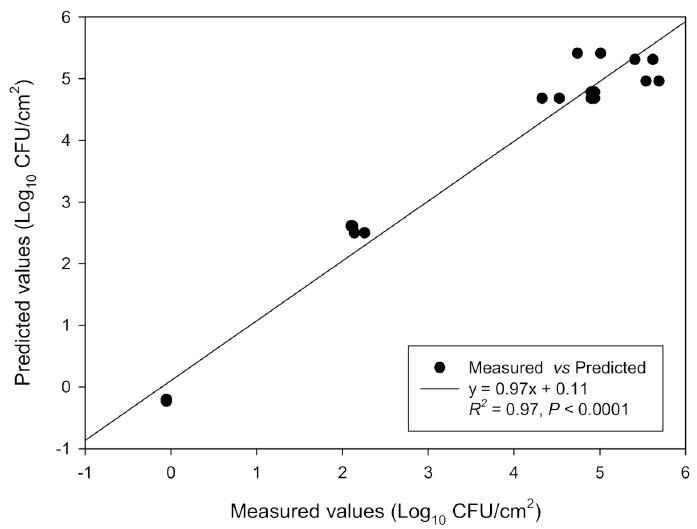
Figure 1. Linear relationship between the measured and predicted data for the concentrations of the attached to SS coupons populations (Log 10 CFU/cm 2 ) of the four-strain L. monocytogenes cocktail. The mathematical equation of the regression plot, together with its regression coefficient ( R 2 ), are also shown. Dots represent the mean values of all experiments included in the CCRD ( n = 20; i.e., those shown in Table 1). For more clarity, the bars of standard deviations have been omitted.